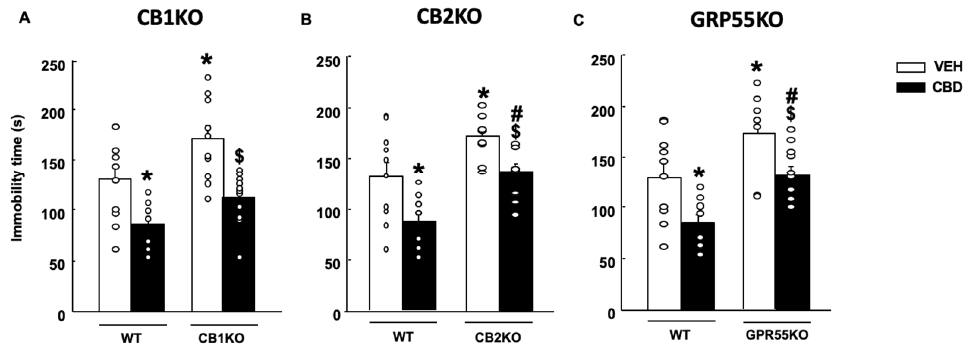
Figure 5. Effects of a single administration of cannabidiol (CBD) at 20 mg/kg (i.p.) on coping behaviors in the tail suspension test in mice lacking the cannabinoid receptor 1 (CB1KO) ( A ), lacking the cannabinoid receptor 2 (CB2KO) ( B ) and lacking the G-protein-coupled receptor 55 (GPR55KO) ( C ). The behavioral evaluation was developed 1 h and 30 min after administration of CBD (or vehicle (VEH)). Columns represent the means and vertical lines ± SEM of immobility time (s). Results from CD1-VEH and CBD (20 mg/kg) groups have been included for comparative purposes. * Values from groups that were different from wild-type (WT)-VEH-treated mice (two-way ANOVA followed by Student–Newman–Keuls test, p < 0.05). $ Values from groups that were different from KO-VEH treated mice (two-way ANOVA followed by Student–Newman–Keuls test, p < 0.05). # Values from groups that were different from WT CBD-treated mice (two-way ANOVA followed by Student–Newman–Keuls test, p <